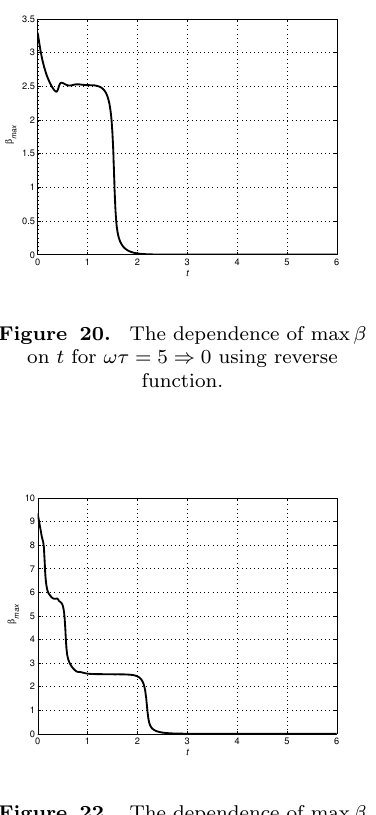
Figure 23. The dependence of β ( l,t i ) on l for ωτ = 12 ⇒ 0, t f = 6 and using the reverse function.